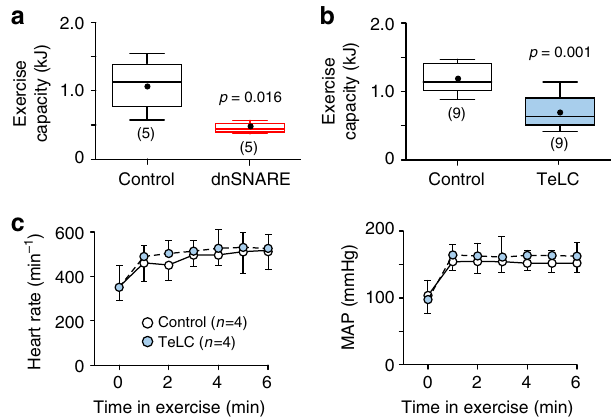
Fig. 5 PreBötC astrocytes determine the exercise capacity. a , b Summary data illustrating the effects of dnSNARE or TeLC expression in preBötC astrocytes on exercise capacity. p values — Mann – Whitney U rank test. c TeLC expression in preBötC astrocytes had no effect on the cardiovascular responses to exercise. MAP — mean arterial blood pressure. Number of animals in each experimental group is indicated in parentheses. Data are presented as means ±